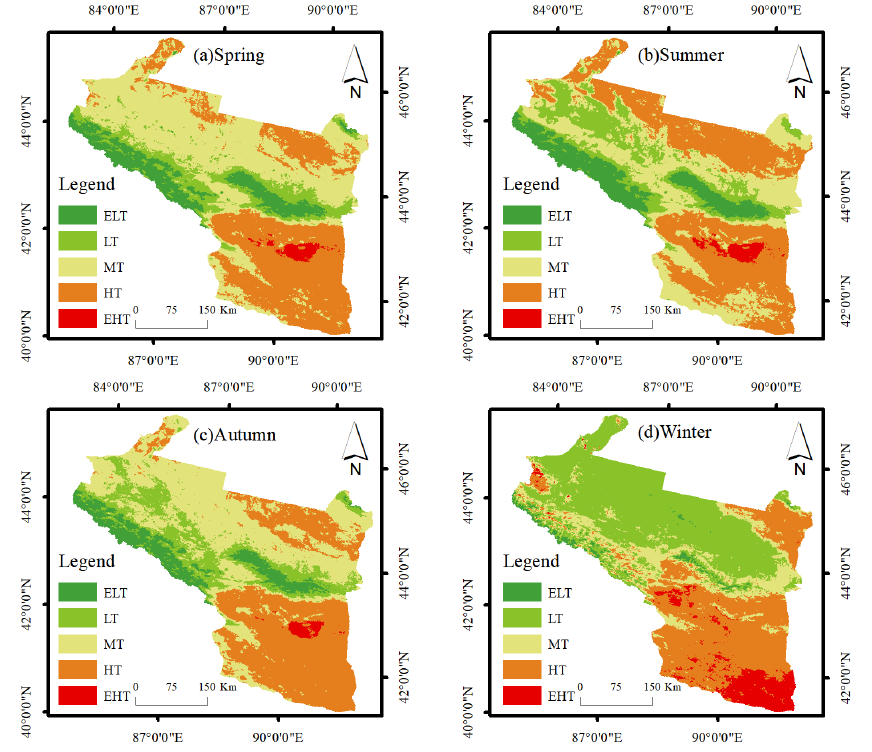
Figure 4. Average LST by season from 2003 to 2020. Table 2. Area of each grade of LST and its